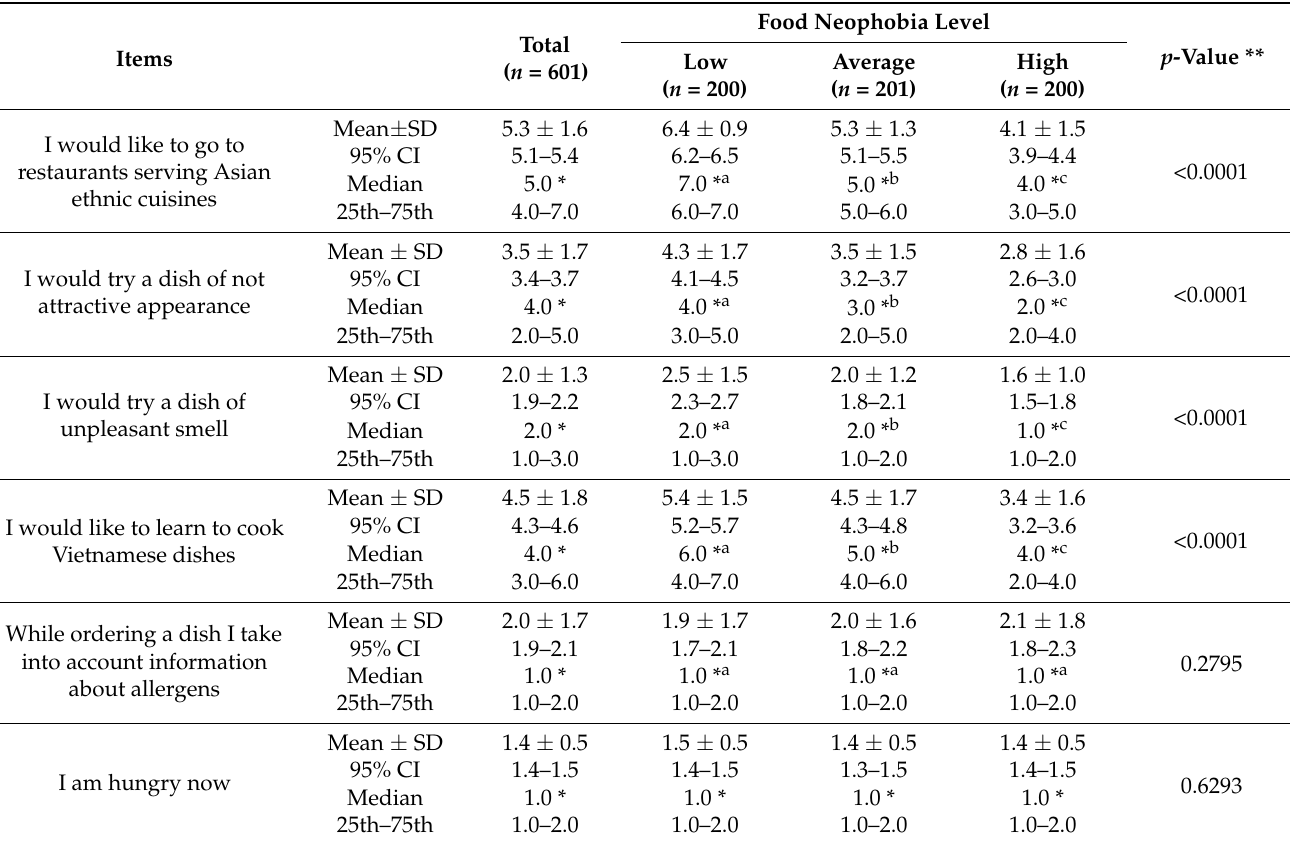
Table 4. The comparison of the general approach towards Vietnamese cuisine and towards information about allergens, accompanied by hunger sensation, stratified by food neophobia level of participants.